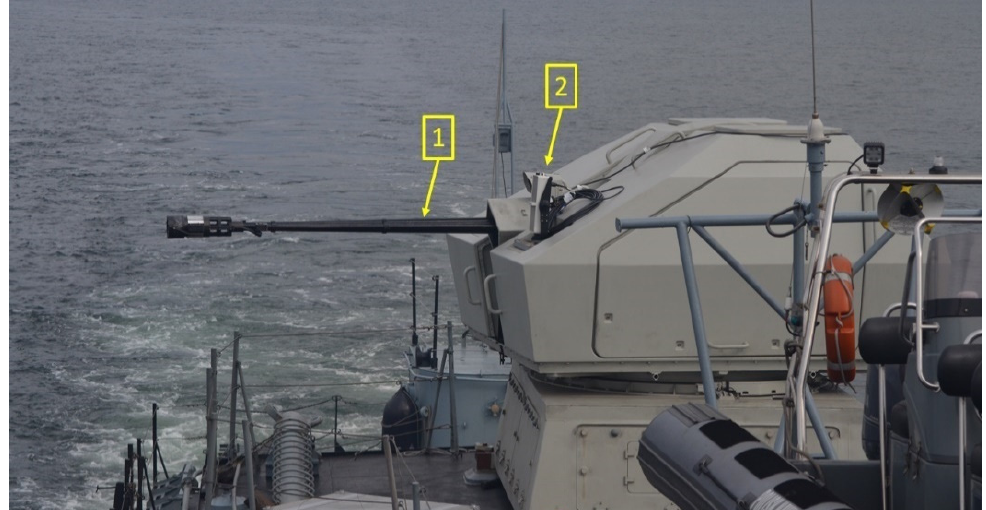
Figure 5. Investigated launching system (1) with Doppler radar (2).